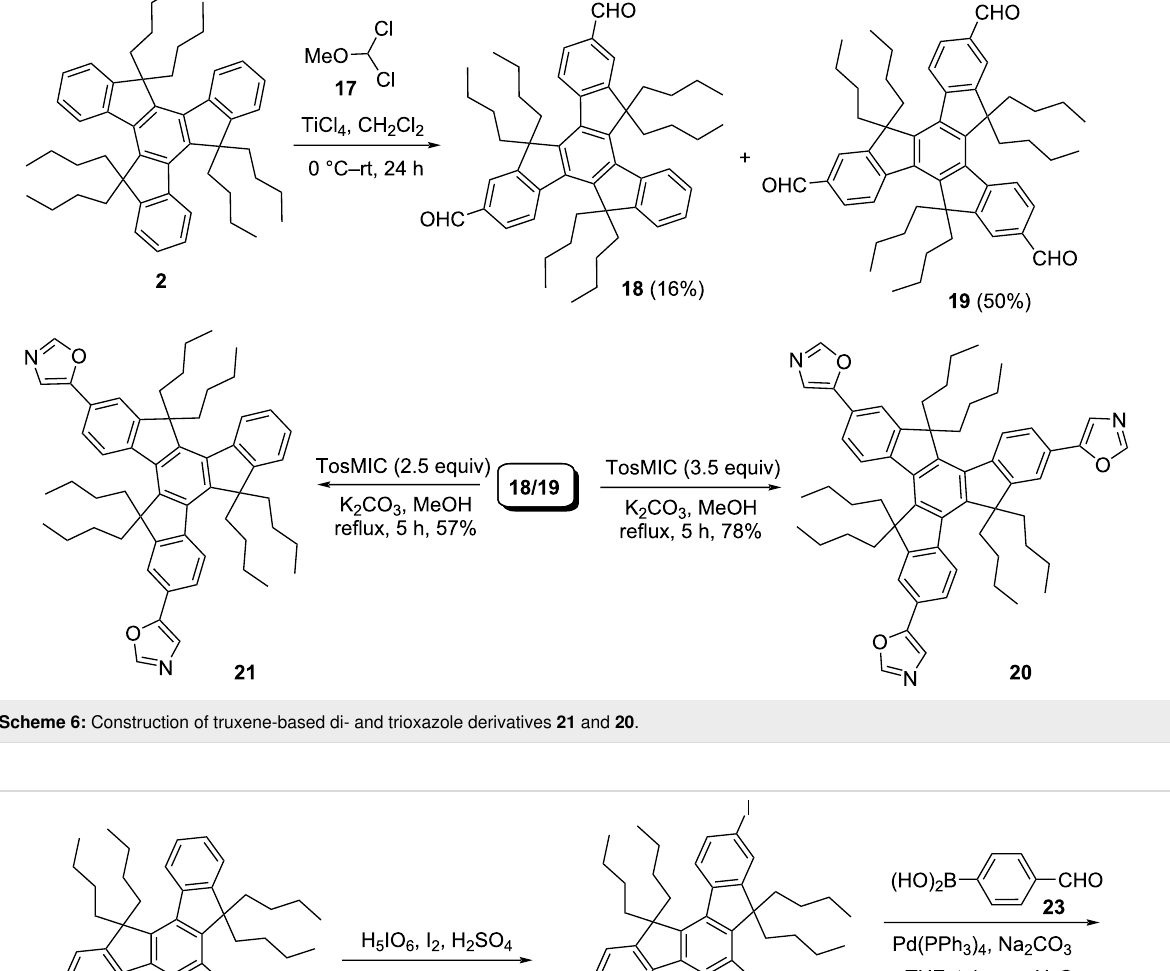
Scheme 6: Construction of truxene-based di- and trioxazole derivatives 21 and 20 .